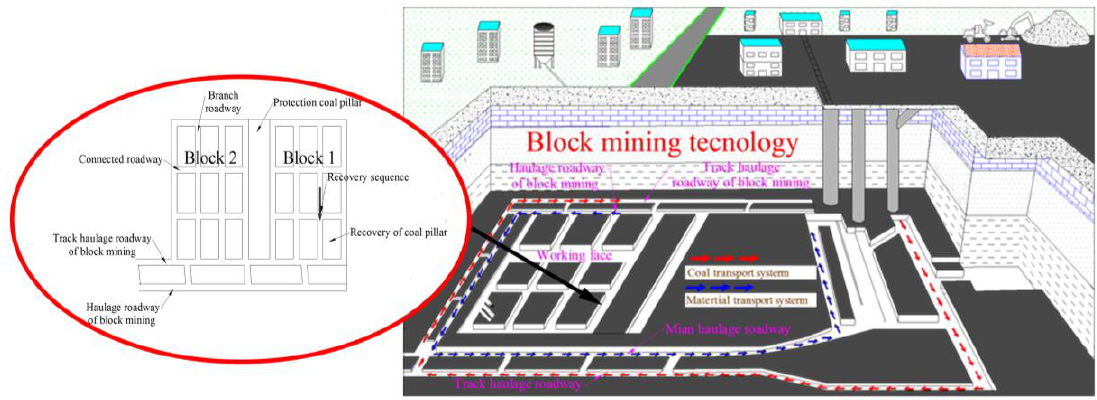
Figure 1. A typical shortwall block mining (SBM) system and the layout of the working face.